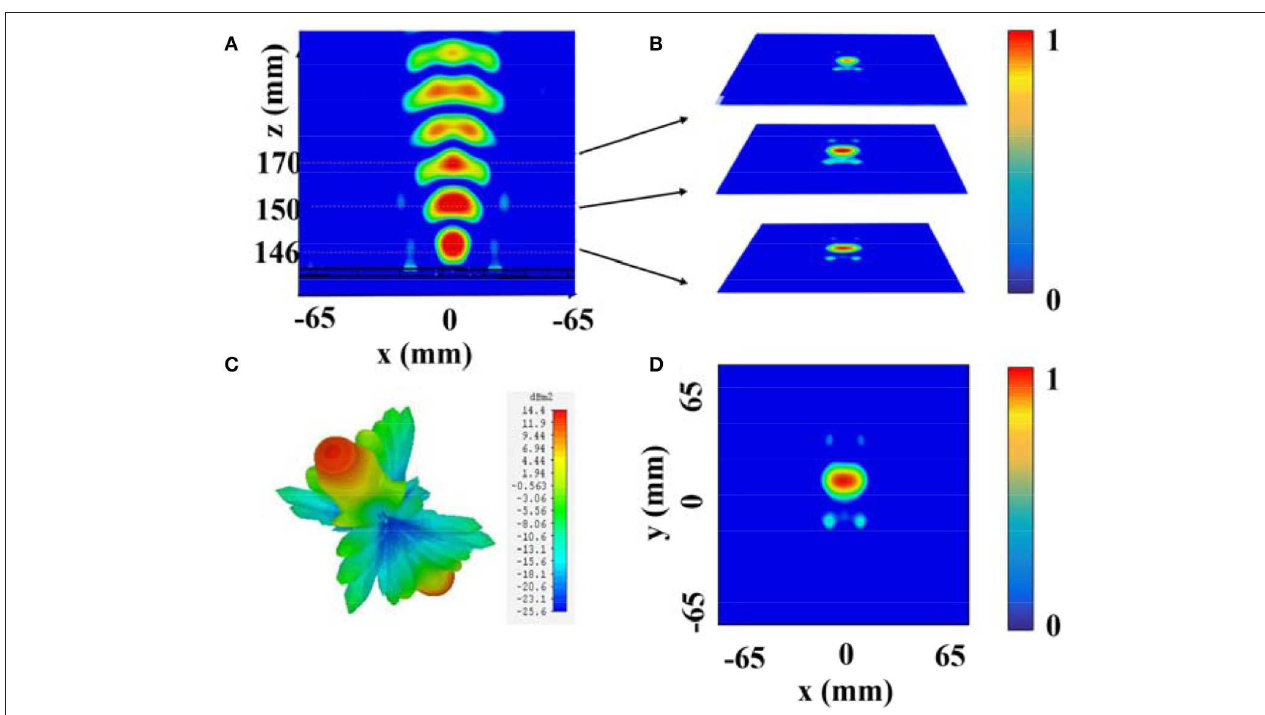
FIGURE 4 | (A) The electric-field energy density distribution in the x – z plane. (B) The electric-field energy density distribution in the x – y plane at z = 146mm, z = 150mm, and z = 170mm, respectively. (C) 3D radiation pattern at 19.6 GHz (D) . The reflected electric-field intensity distribution in the x – y plane and at the focus ( z =